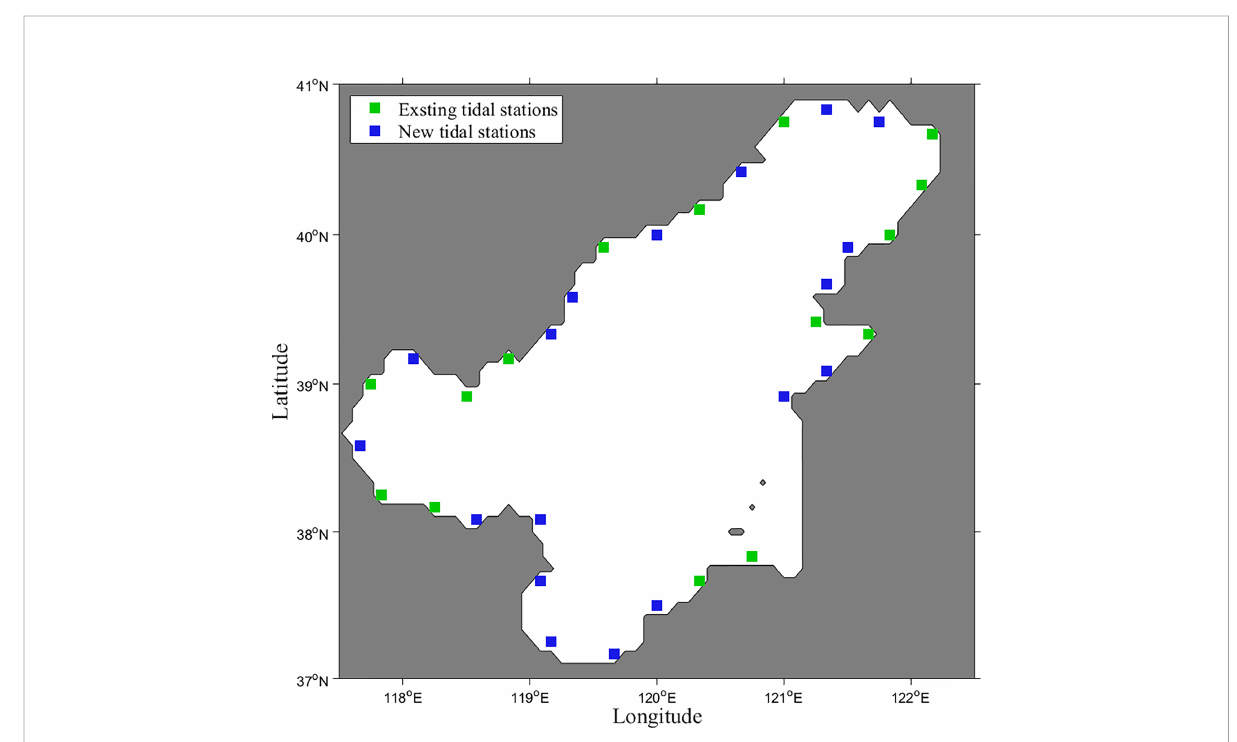
FIGURE 9 Grid map of new tidal station in the Bohai Sea (blue grids represent new tidal stations and the green grids represent existing tidal stations).